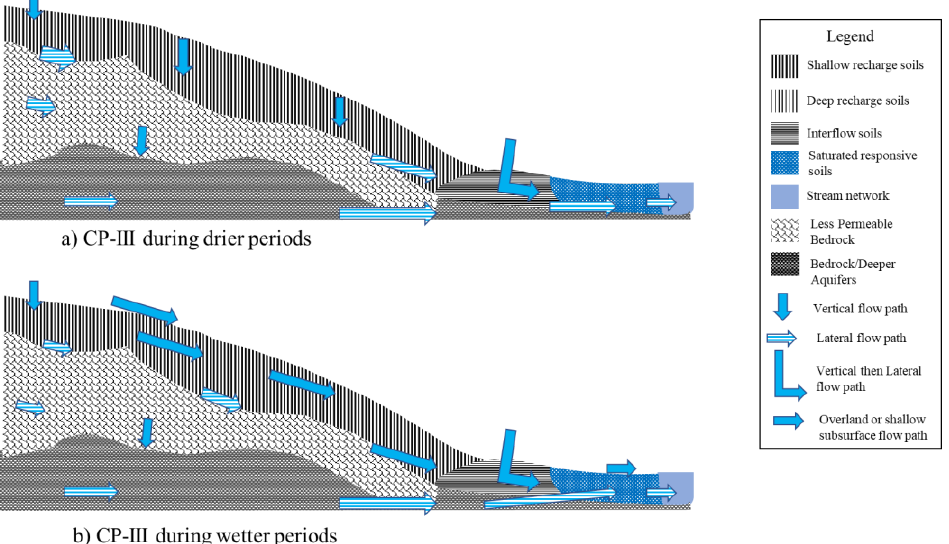
Figure 5. Flow path diagrams for ( a ) the drier periods and ( b ) wetter periods for CP-III.